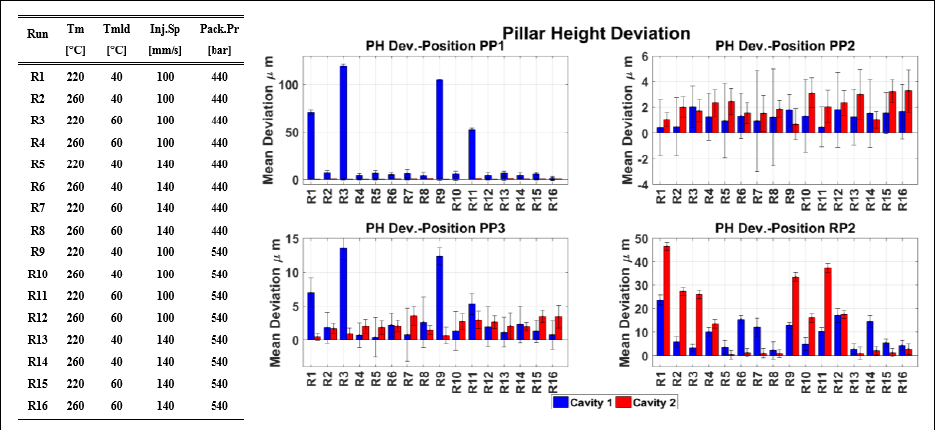
Figure 13. Comparison of average pillar height deviation (mold-part) per position for Cavities 1 and 2.